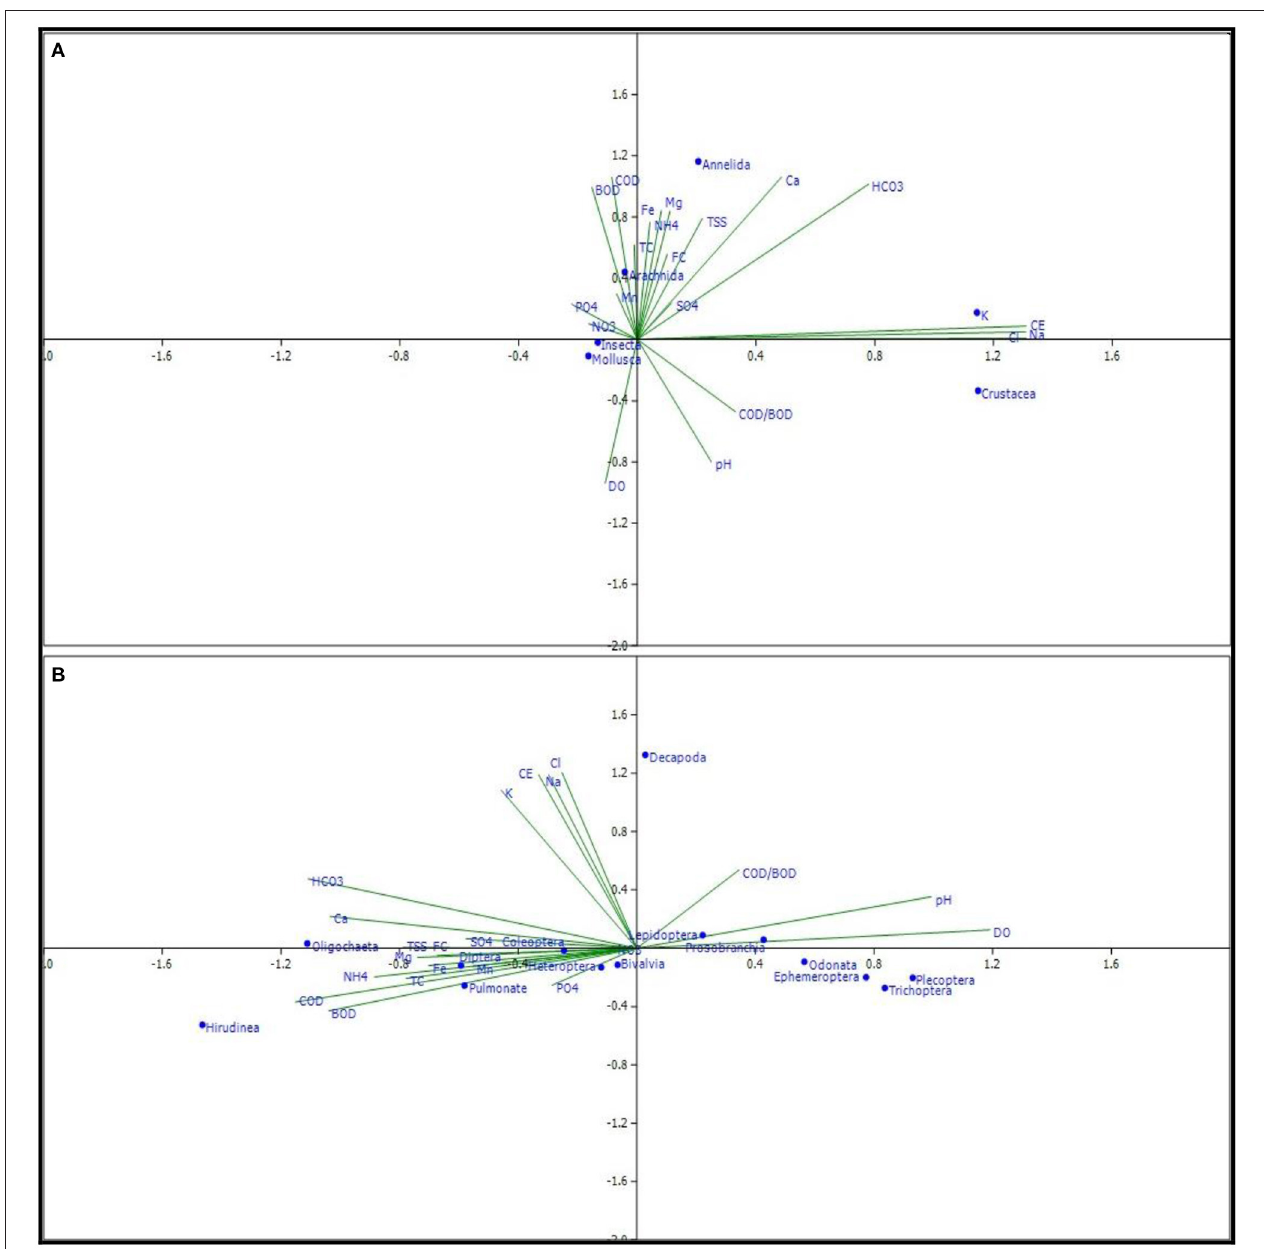
FIGURE 2 | A canonical correspondence analysis (CCA) biplot showing the association between water quality parameters and abundance of macroinvertebrate phylum–class (A) and subclass–order (B) resolution.